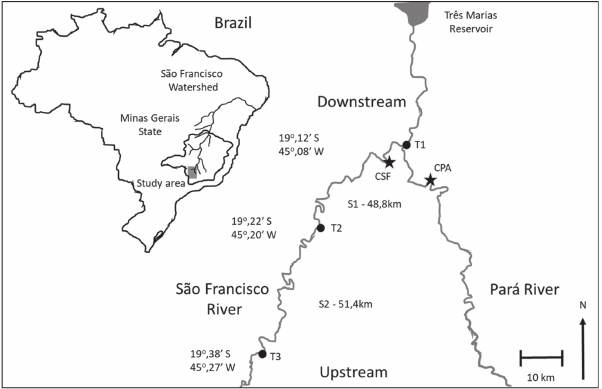
Fig. 1. Map of the São Francisco River watershed, Minas Gerais, Brazil detailing the study area in the upper part of the basin. CSF and CPA: capture/release points at São Francisco and Pará rivers; T1–T3: telemetry stations; S1 and S2: river stretches. The length of river stretch is shown in river